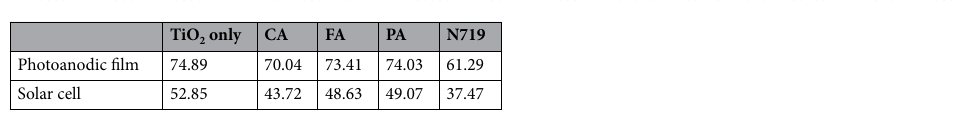
Table 3. VLT (%) values of dye-grafted films and